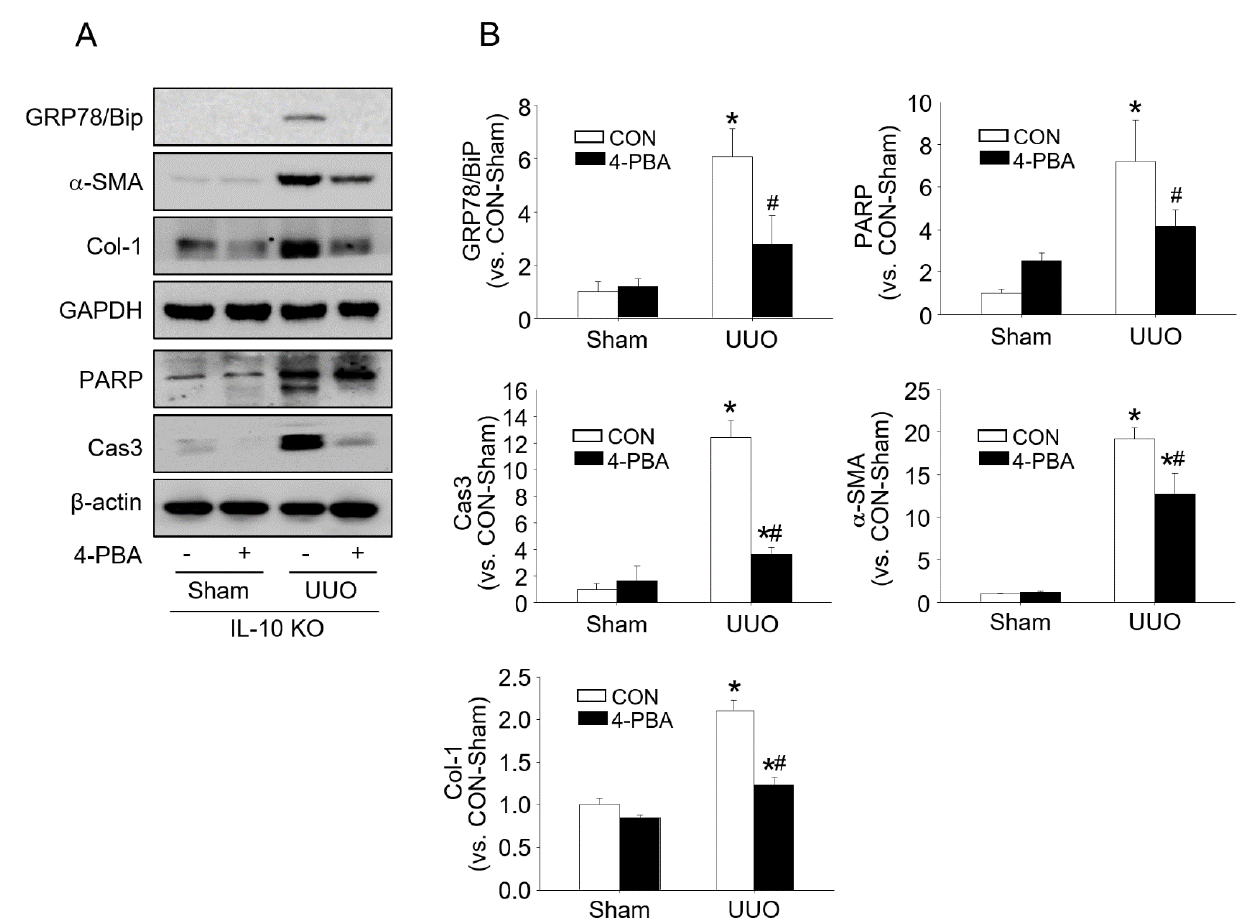
Figure 4. 4-PBA treatment inhibited ER stress, fibrosis, and apoptosis 7 days after UUO in IL-10 − / − mice. ERS-related protein (BiP), apoptosis-related protein (PARP and Cas3), and fibrosis-related protein (α -SMA and Col-1) levels in 4-PBA or control saline treated IL-10 − / − mice were determined with Western blotting ( A ). GAPDH was used as the loading control. Densities of bands were quantified using ImageJ software ( n = 3 to 4) and bars indicate means ± SEMs ( B ). Results are presented as means ± SEMs ( n = 3 to 4) * p < 0.05 vs. IL-10 − / − -sham mice not administered 4-PBA, # p < 0.05 vs UUO induced CON mice.